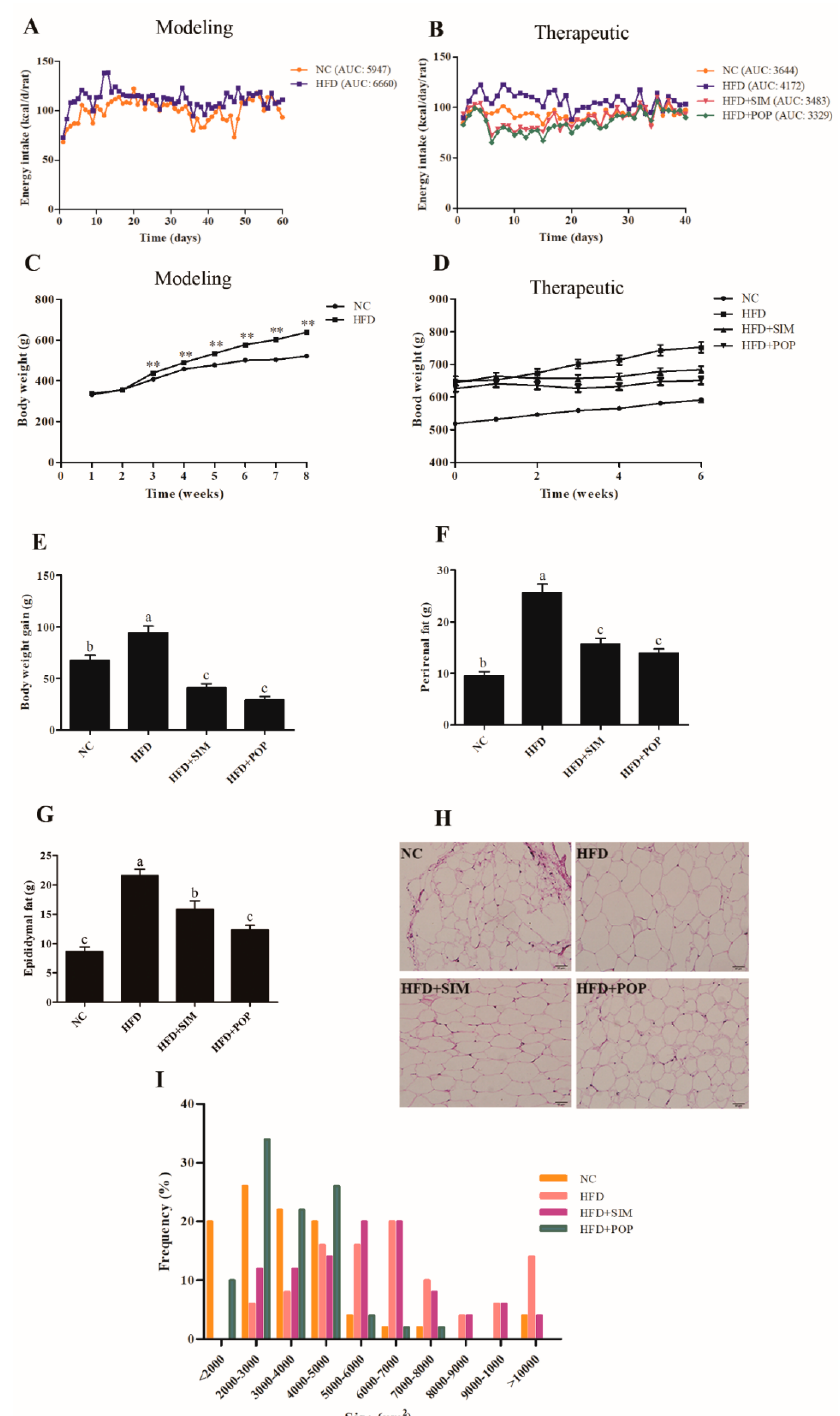
Figure 1. Effects of POP on HFD-induced obesity in rats. ( A ) Energy intake during modeling time. ( B ) Energy intake during treatment. ( C ) Body weight during modeling time. ( D ) Body weight during treatment. ( E ) Body weight gain during treatment. ( F ) Perirenal fat. ( G ) Epididymal fat. ( H ) Epididymal adipocyte microsections. ( I ) Epididymal adipocyte size evaluated by ImageJ software. NC = normal control, HFD = high-fat diet, HFD + SIM = HFD with simvastatin (1.8 mg/kg), HFD + POP = HFD with P. odoratum polysaccharides (400 mg/kg). AUC = Area under curve. All data are presented as means ± SEM. ** p < 0.01 for HFD ( n = 30) versus NC ( n = 10) in ( C ). a–c Mean values not sharing a common superscript were significantly different among the groups ( n = 10 for each) ( p <